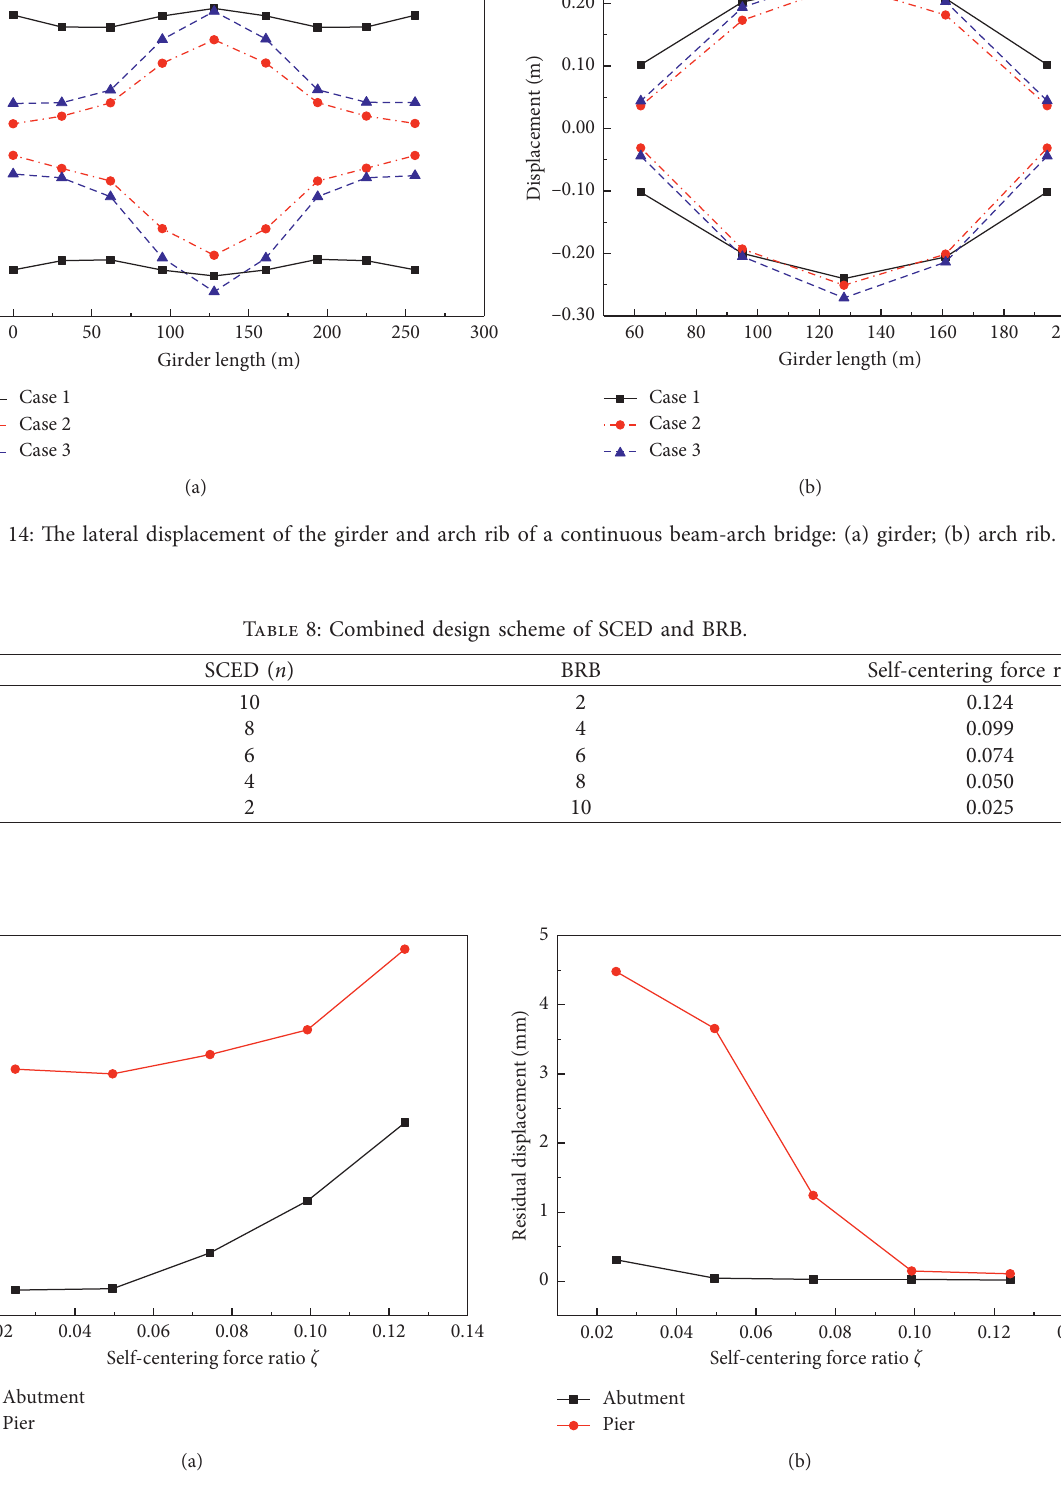
Figure 15: The relationship between self-centering force ratio and displacement, residual displacement of braces: (a) displacement; (b) residual